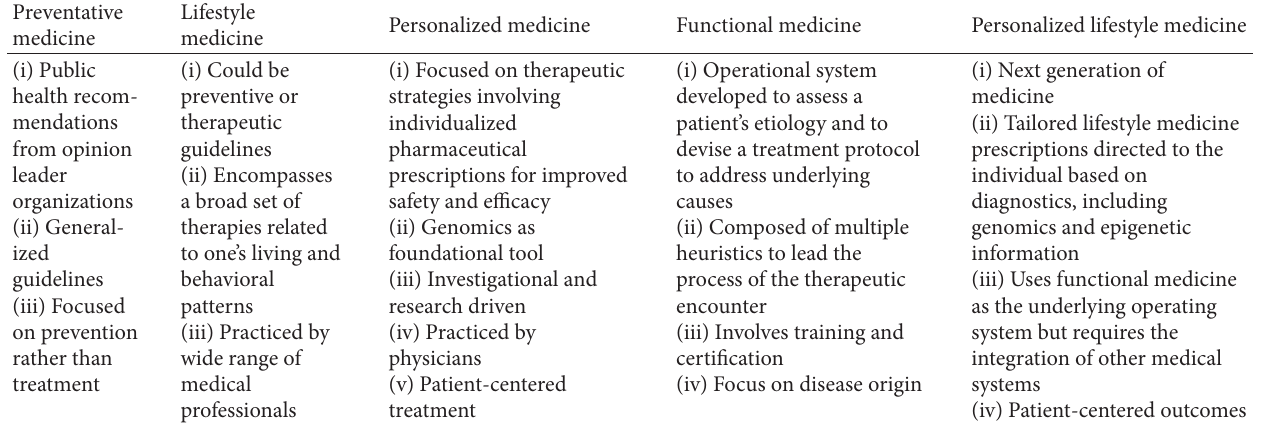
Table 1: Differentiation among medical